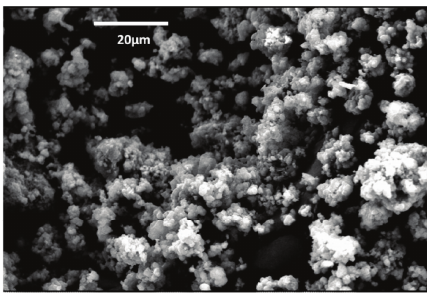
Figure 2: SEM image collected on the photoreactive sorbent anatase TiO 2 @ZY.